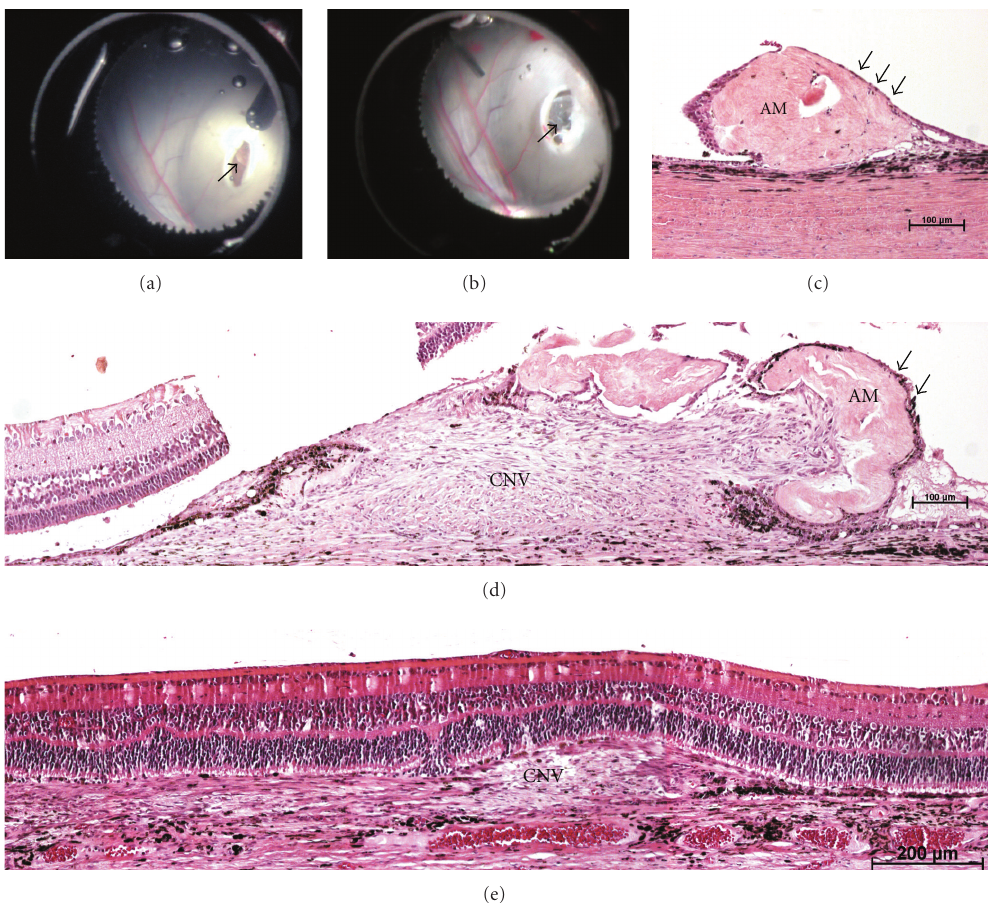
Figure 1: (a) Peroperative photo of the bleb with the retinotomy. Arrow points at the lesion in the retinal pigment epithelium trough the retinotomy. (b) Peroperative photo from the same operation as (a). The arrow points now at transplanted amniotic membrane (AM) covering the induced lesion. (c) Micrograph of the subretinal space (SRS) in a pig after transplantation of AM. The AM is in close contact with the RPE and covers the lesion completely. AM is totally covered with RPE cells similar to the normal host RPE and no CNV is observed. (d) Micrograph of the SRS in a pig after transplantation of AM. AM covers in this case only partly the induced lesion. Formation of a choro- idal neovascularisation (CNV) is seen. AM is in contact with the RPE at one side and the RPE has covered the retina near side of the AM. We have not observed CNV penetrate the AM, but the CNV rather tends to “crawl under” the membrane out into the SRS. (e) Micrograph of a control eye that received mechanical damage to RPE/Bruch’s membrane, but did not receive any AM. A large CNV is seen in the SRS. The peripheral part is covered with RPE, whereas the central part is in close contact with the photoreceptors. The scale bars are: (a) 100 µ m, (b) 100 µ m, and (c) 200 µ